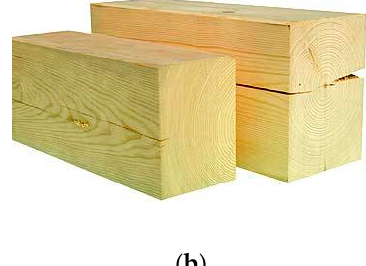
Figure 7. ( a ) Timber is an orthotropic material: the three principal directions (tangential, radial and longitudinal) depend on the grain orientation; ( b ) differential shrinkage can produce significant damage. Shrinkage is typically very high along the tangential direction.